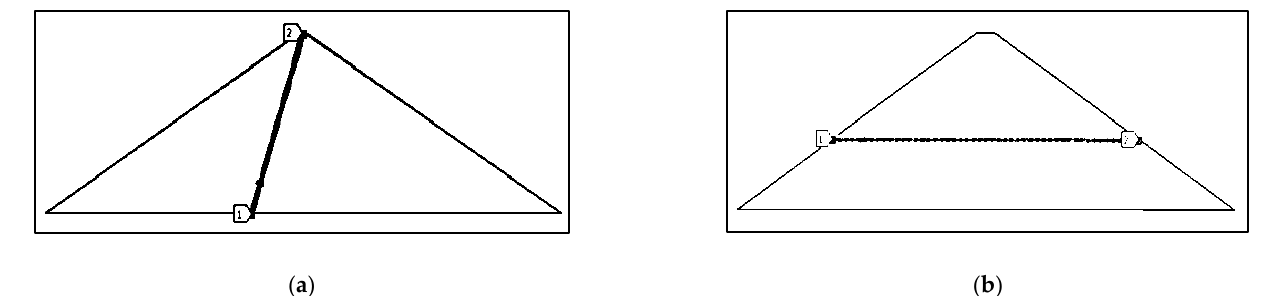
Figure 10. Choice of the studied areas for the comparison of variables: ( a ) column considered and ( b ) row considered.